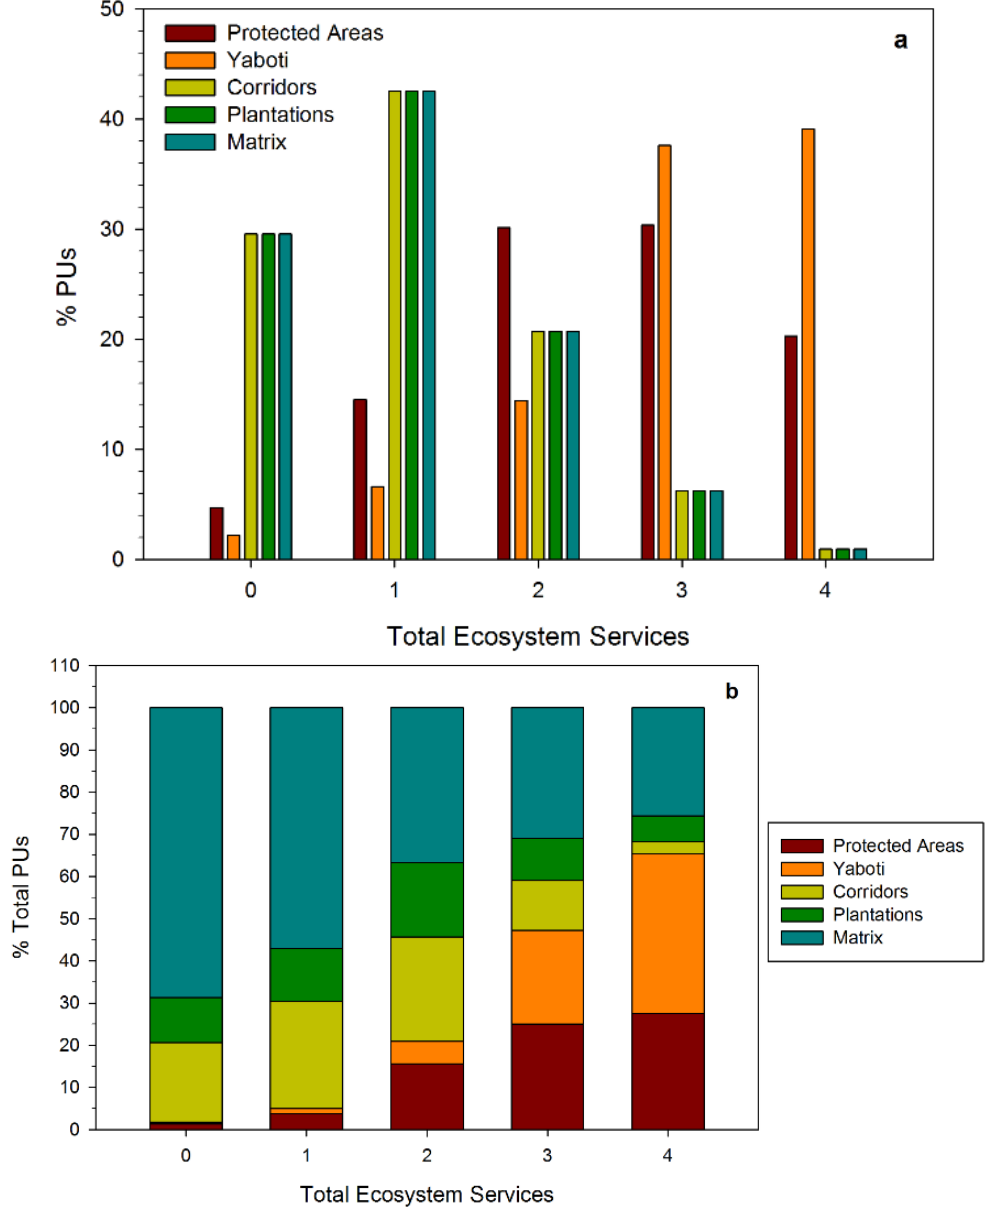
Figure 6. Based on the Marxan best solutions for all targets ( a ) percentage of planning units within each region of the Misiones landscape ( i.e. , Protected Area, Yabotí, etc .) that provide zero through all four targets; and ( b ) within different total target categories, percentage of best-solution planning units from each region of the